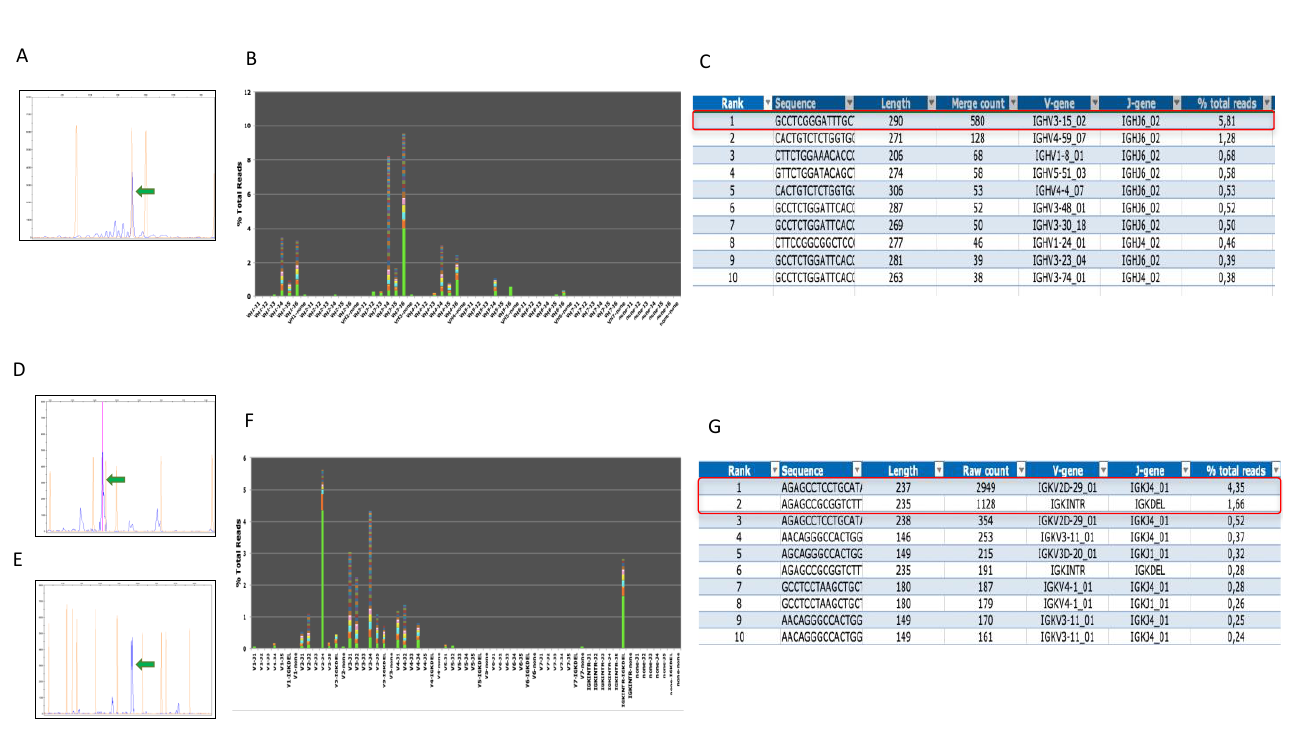
Figure 4. IGH gene rearrangement of the skin lesion of patient 2 ( A – C ) and IGK gene rearrangement of the skin lesion of patient 3 ( D – G ) by PCR-based ( A , D , E ) and NGS-based ( B , C , F , G ) methods. In patient 2, a predominant peak over a polyclonal IGH rearrangement observed by PCR (( A ), green arrow) was confirmed by NGS analysis using FR1 primer sets. A productive VH3-J6 clone was detected in 4% of total reads as shown in the merged read summary graph ( B ) and output table ( C ). In patient 3, IGK assay demonstrated two dominant peaks (( D ), green arrows). One was obtained using the primers amplifying the Vk-Jk region and corresponded to an unproductive VK2-J4 rearrangement ( F ) detected by NGS analysis in 4.35% of total reads ( G ). The other peak was observed using the primers covering the Vk/Jk-Ck (INTR)-kappa deleting element (Kde) region ( E ) and corresponded